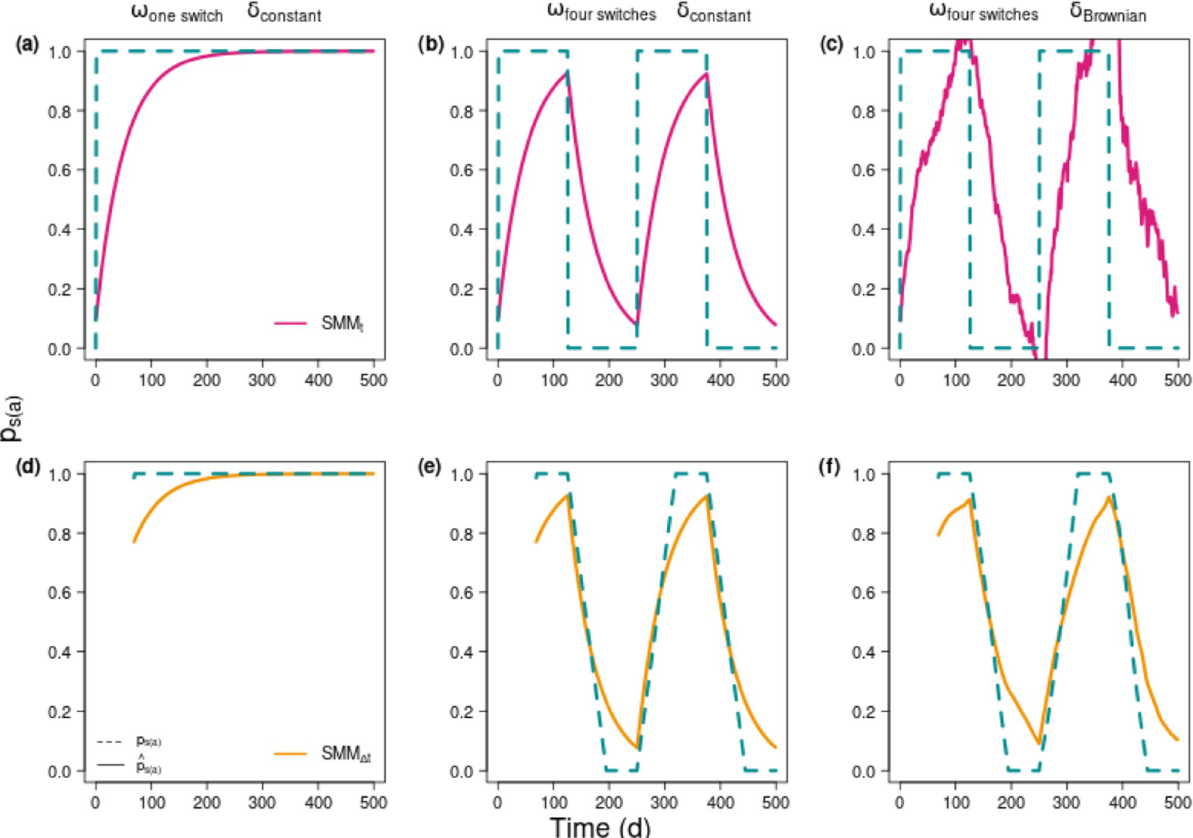
Fig 4. Estimated contributions of source a ( ^ p solid line) to a consumer’s diet compared to reference ( p s ( a ) dashed line). ^ p s ð a Þ isotopic composition of consumer ( δ ( t )) simulated using DMM and forcing food sources ( δ c represents ^ p estimated instantly from the SMM t (pink lines), second row (d-f) represents integrative estimation of ^ p s ð a Þ The reference diet ( p s ( a ) ) (turquoise dashed lines) corresponds to the forcing diet as input of DMM, at each t for SMM t (a-c) or averaged over the time window ( Δ t )—equated to twice the isotopic half-life (i.e., Δ t = 2 ln(2)/ λ and equals 69 d for these simulations) for SMM Δ t (d-f). For SMM Δ t the ^ p values start at the 70 th day by integrating the sources over previous 69 d. The columns represent different scenarios of the experimental design: ω was (a, d) 0.002 d -1 (one diet switch), (b, c, e, f) 0.008 d -1 (four diet switches), and the isotopic values of the food sources were (a, b, d, e) constant or, (c, f) variable. In the three scenarios λ is constant and set at an intermediate value ( λ = 2.10 − 2 d -1 ).